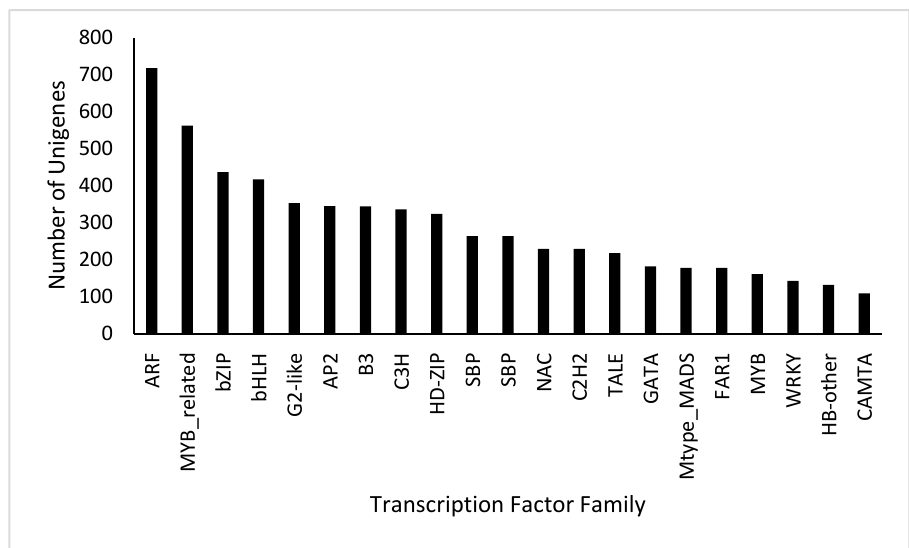
Figure 4. Top 21 families of transcription factors identified in the A. marmelos leaf.